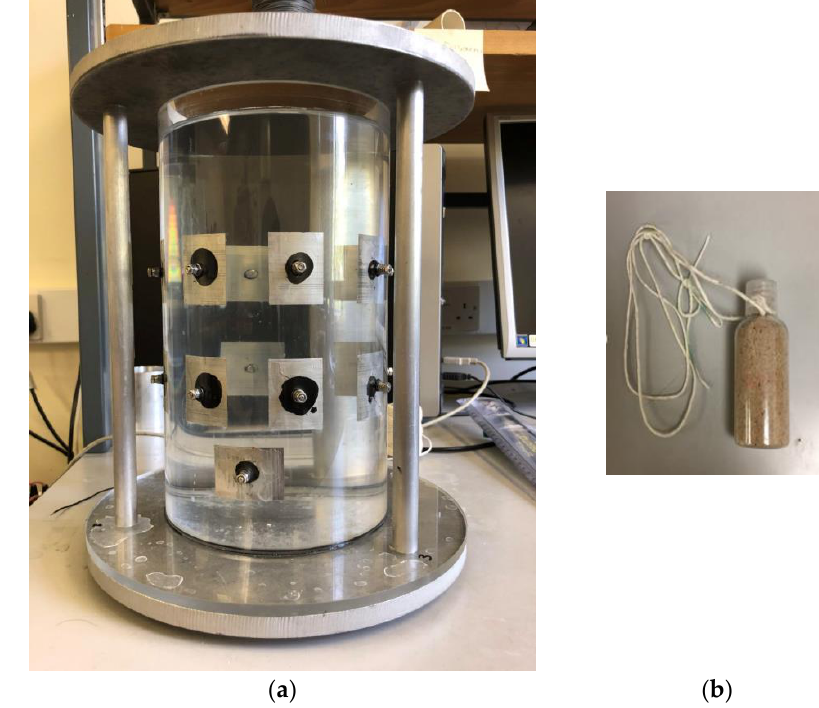
Figure 13. ( a ) Phantom of the 3D experimental test: 16 electrodes composed with 2 rings of 8 are utilized for excitation and measurement. The stainless-steel boards are applied to the tank as the main part for the pipe to sit on, which avoid the problem of leaking. ( b ) Non-conducting inclusion of 3D experiment test: a plastic bottle filled with sands to make sure the inclusion could sink down to the bottle, where tap water was chosen as the background and continuous phase.